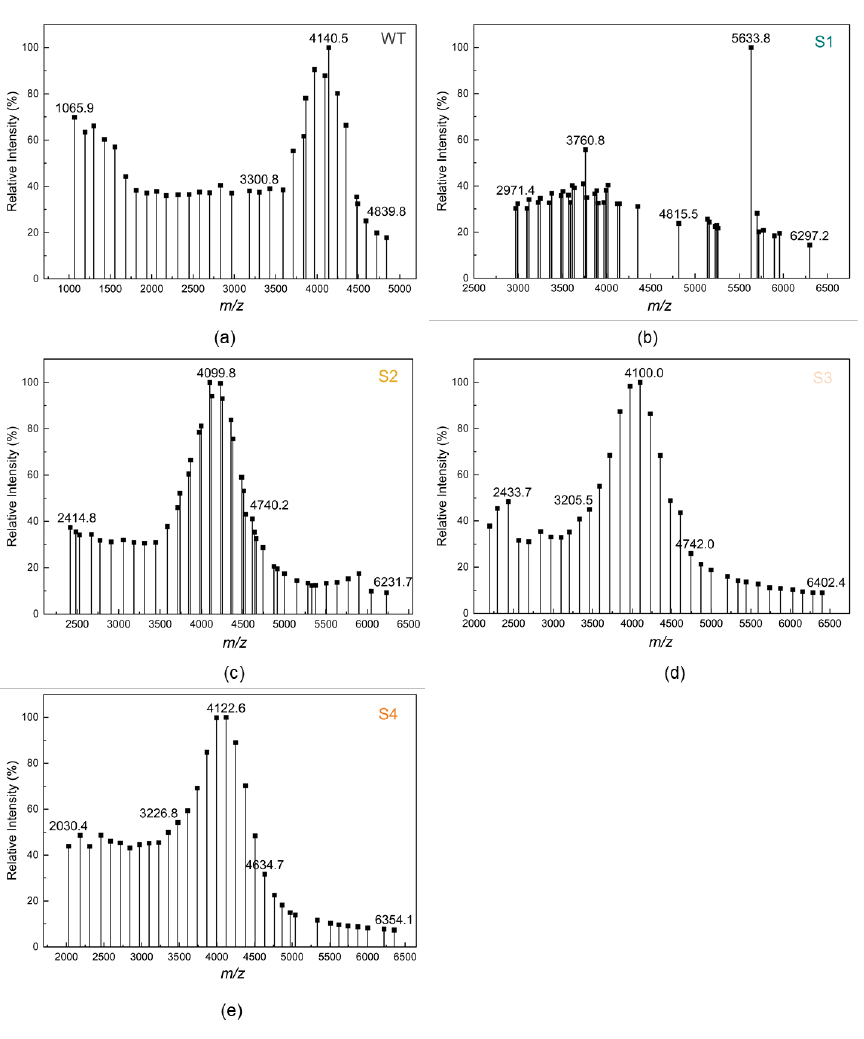
Figure 4. Matrix-assisted laser-resolved ionization time-of-flight mass spectrometry (MAL-DI-TOF- MS) analysis of the ε -PL produced by the pldII repressed strains. ( a ) ε -PL produced by WT strain; ( b ) ε -PL produced by S1 strain; ( c ) ε -PL produced by S2 strain; ( d ) ε -PL produced by S3 strain; ( e ) ε -PL produced by S4 strain.